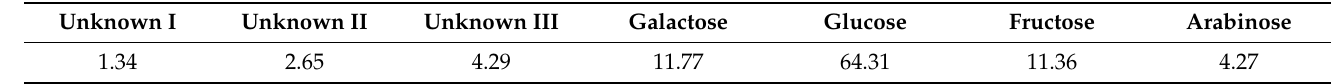
Table 2. Carbohydrate composition of crude polysaccharide from R. rugosa root (CPL-Rx) expressed in